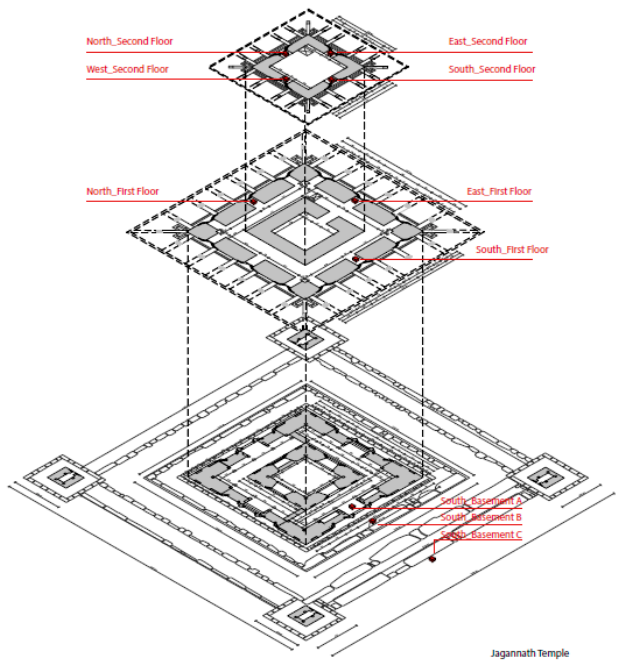
Figure 2. Locations of the velocimeter, Jagannath Temple.